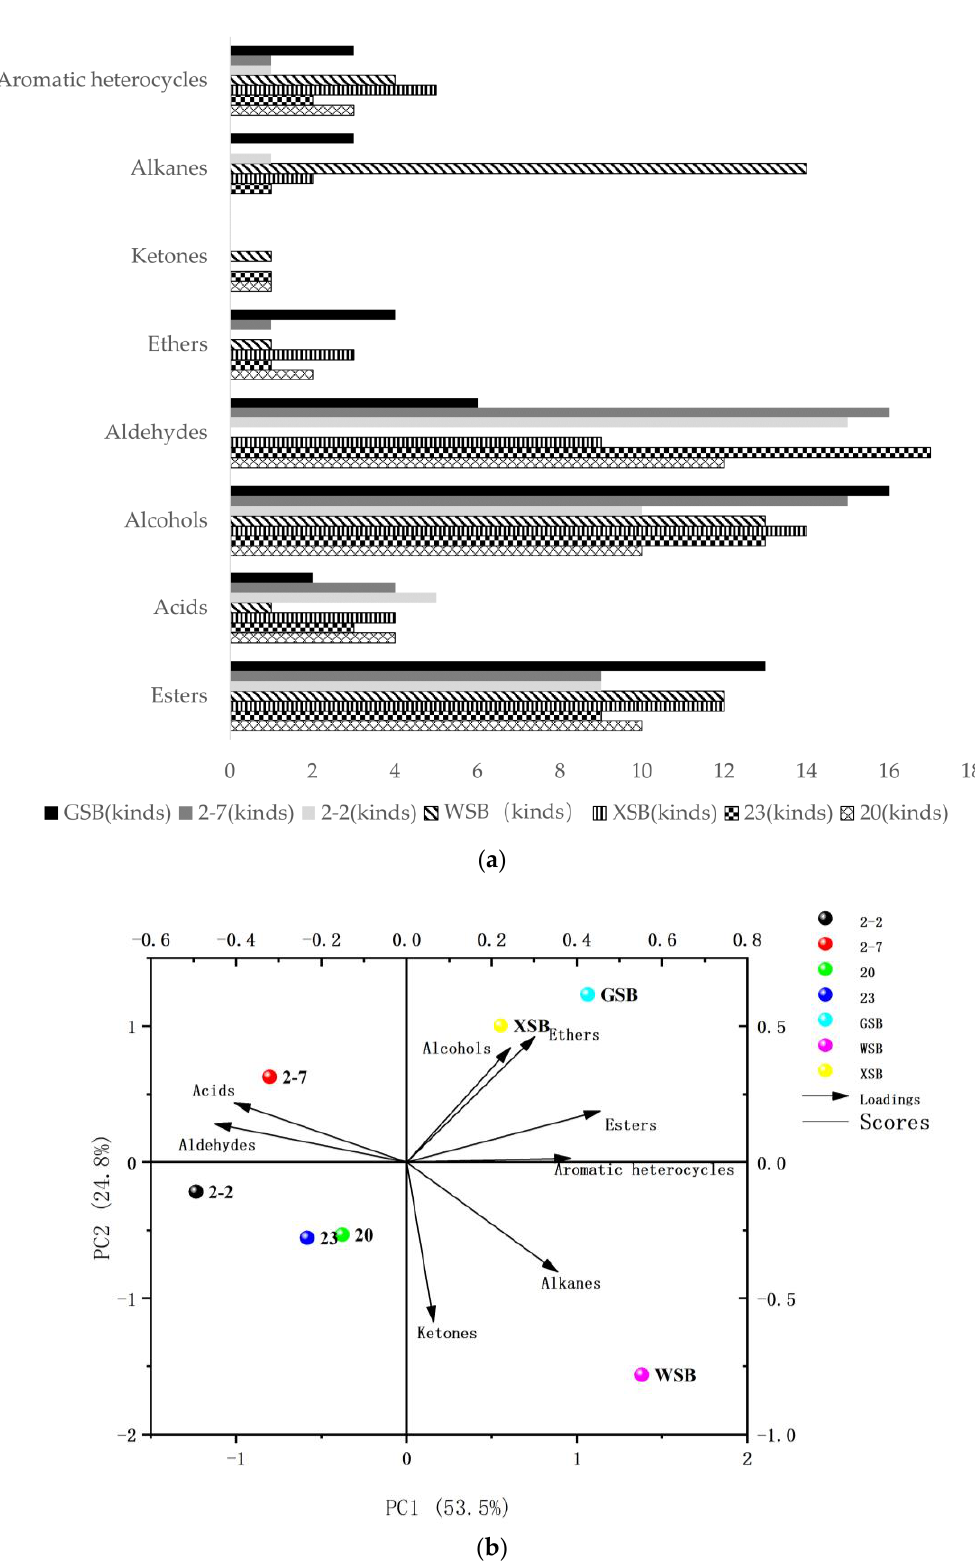
Figure 4. Statistical results of volatile compounds of different traditional sourdoughs (( a ): bar chart; ( b ): principal correspondence analysis (PCA)).